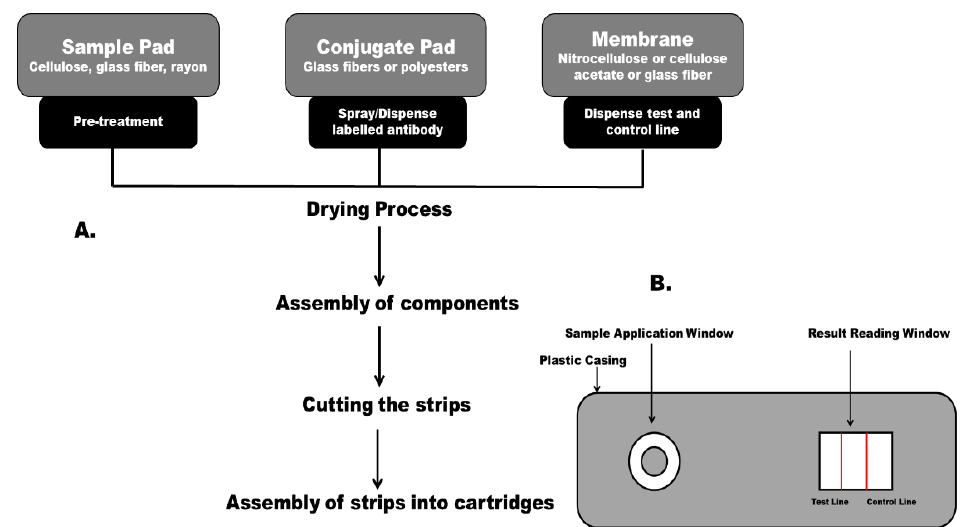
Figure 2. ( A ) Outline of manufacturing process for lateral flow tests; ( B ) Top view of a lateral flow immunoassay test